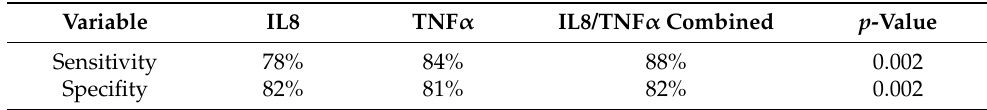
Table 7. The diagnostic values of IL-8 and TNF- α separately and combined in distinguishing between malignant and benign ovarian